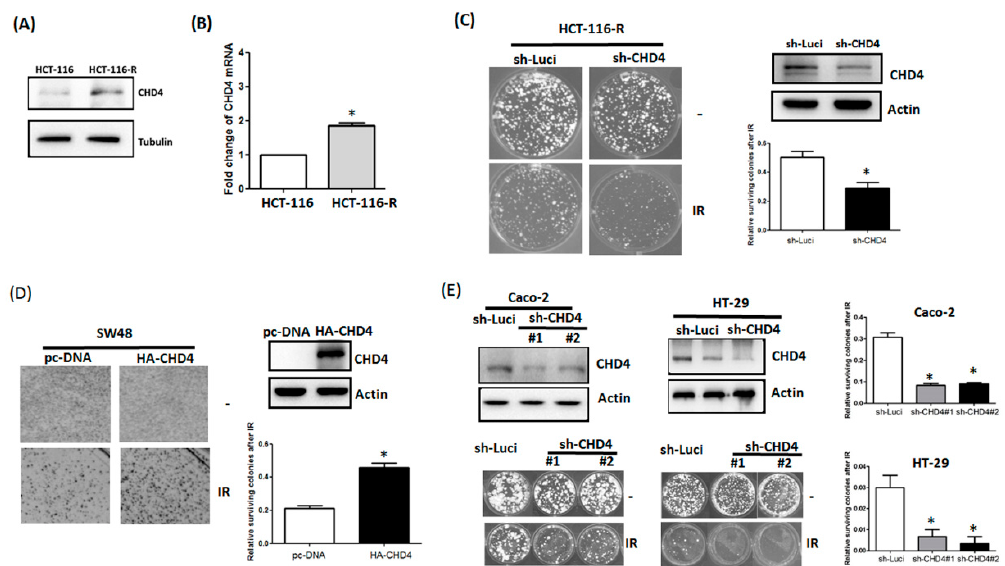
Figure 4. CHD4 regulates the radioresistance in CRC cells. ( A ). Protein expression of CHD4 in HCT-116 and radio-resistant HCT-116-R cells as determined by Western blotting. ( B ) Gene expression of CHD4 was determined by RT-qPCR in HCT-116 and radio-resistant HCT-116-R cells (paired t -test, p values). ( C ) Clonogenic assay with 1x10 3 radio-resistant HCT-116-R cells and HCT-116-R-sh-CHD4 cells after exposure to ionizing radiation (IR) with the indicated dose for 2 weeks (paired t -test, p values). ( D ) Clonogenic assay with 1x103 cells of SW48 cells and SW48-CHD4 overexpressing cells after exposure to IR, with the indicated dose for 2 weeks. (paired t -test, p values). ( E ) Clonogenic assay, with 1 × 10 3 cells of HT-29 cells and Cacco-2-CHD4 knockdown cells after exposure to IR, with the indicated dose for 2 weeks (One-way ANOVA, p values). * indicated p < 0.05.